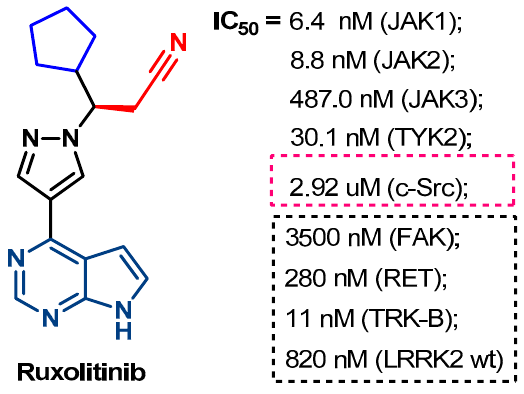
Figure 51. Kinases inhibitory activities of